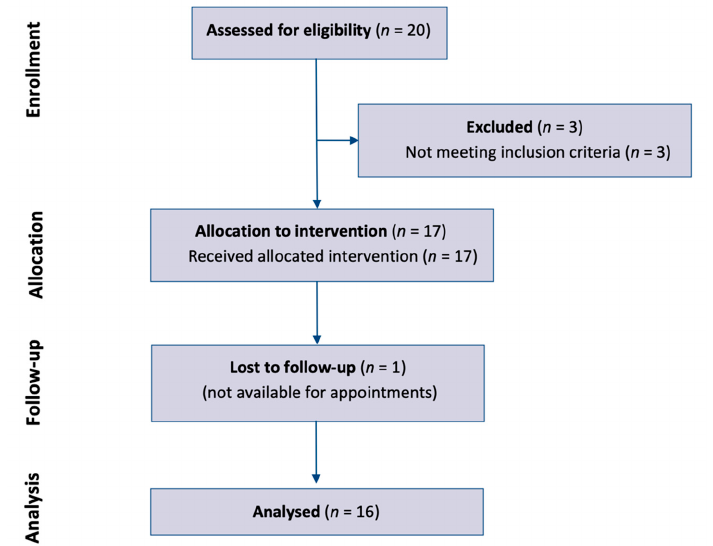
Figure 2. Patient selection process.